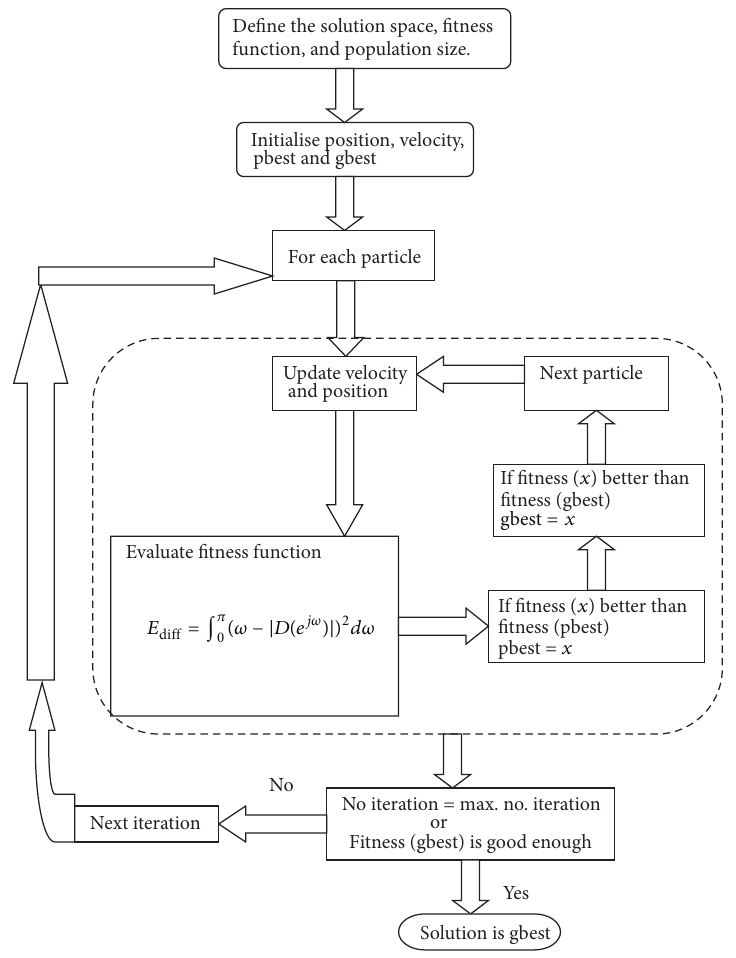
Figure 2: Flowchart of PSO